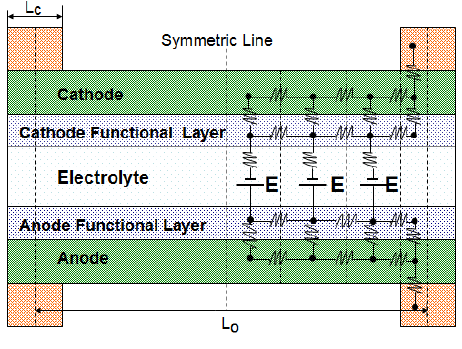
Figure 2. Equivalent electrical circuit for an H-SOFC.